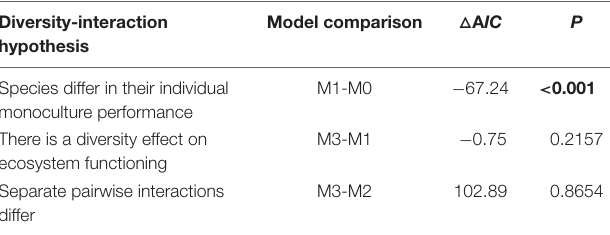
TABLE 2 | Comparisons between hierarchical DI models testing biological hypotheses about the contribution of species identity and interspecific interactions to